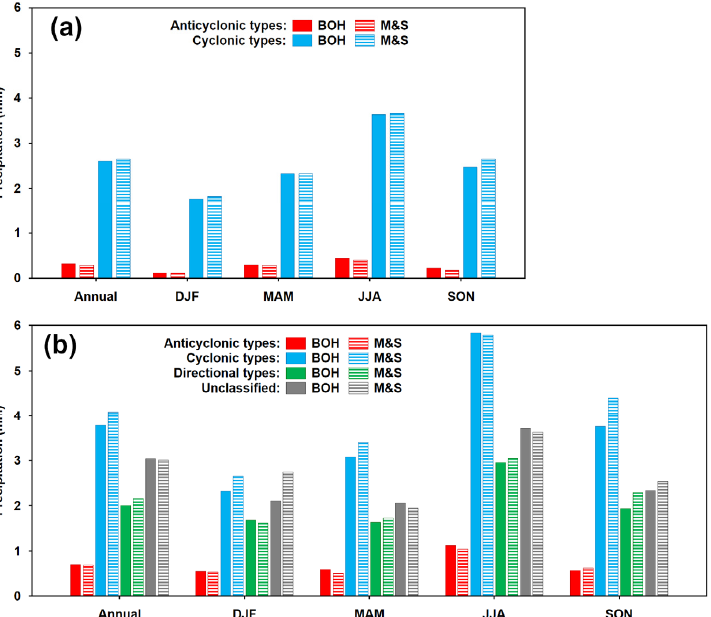
Figure 7. Mean annual and seasonal (DJF: December–February; MAM: March–May; JJA: June– August; and SON: September–November) daily precipitation totals (mm) for the groups of circulation types under the CHMI ( a ) and objective ( b ) classifications in Bohemia (BOH) and Moravia and Silesia (M&S) during the 1961–2020 period.